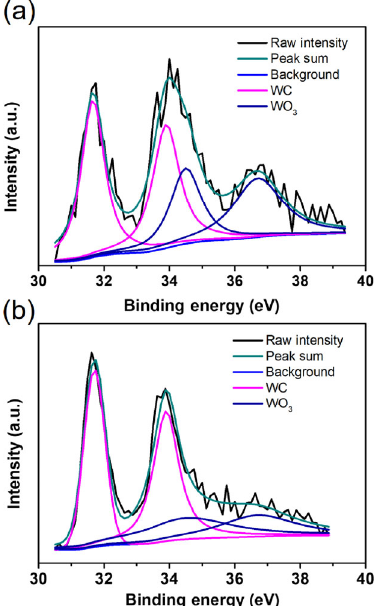
Fig. 7 The XPS of the valence band energy region of W 4f on the wear scars of cemented carbide balls sliding against non-impregnated graphite (a) and impregnated graphite (b) at 160 °C under a load of 8 N.